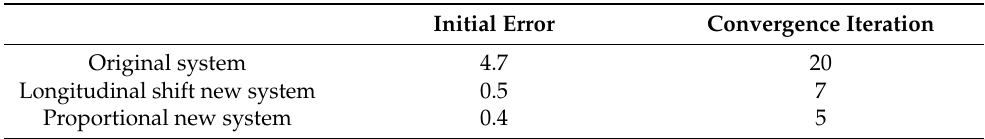
Table 3. Effect of Experience Amplitude Adjusting